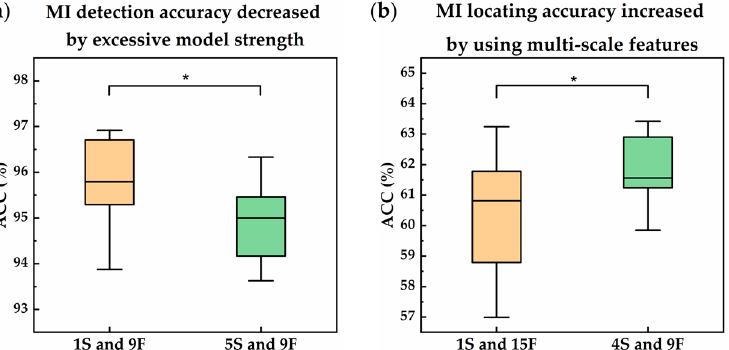
Figure 9. Box plot and significance of the accuracy of the proposed network where 1S indicates models using single-scale features, 9F indicates models using nine filters, and so on. ( a ) Evidence that supports accuracy decrease due to overfitting caused by excessive model strength. The average accuracy decreased from 95.76% to 94.95% ( p < 0.05); ( b ) Evidence that supports using multi-scale features will increase MI locating accuracy. The average accuracy increased from 60.49% to 61.82% ( p < 0.05).